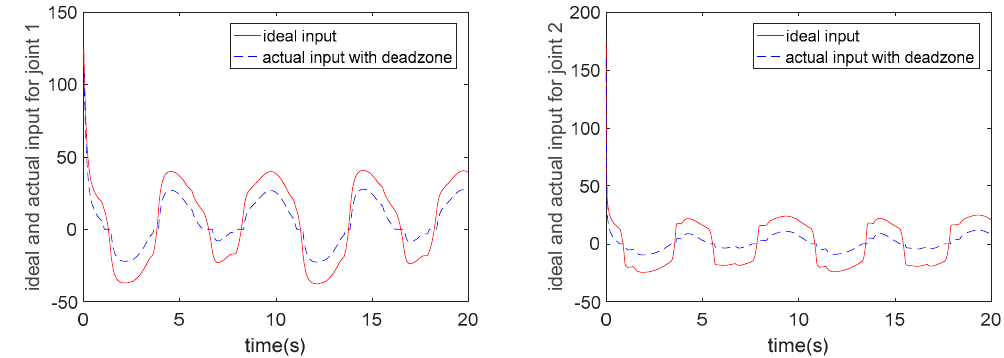
Figure 7. Input signal tracking performance of joint 1 ( left ) and joint 2 ( right ) without dead zone compensation.